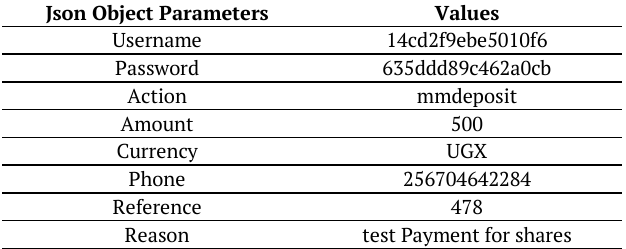
Table 1. Sample Json object of